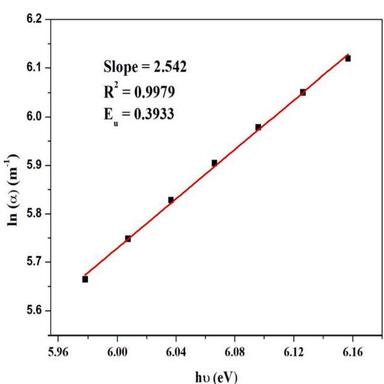
Variation of photon energy hν verses ln (α).